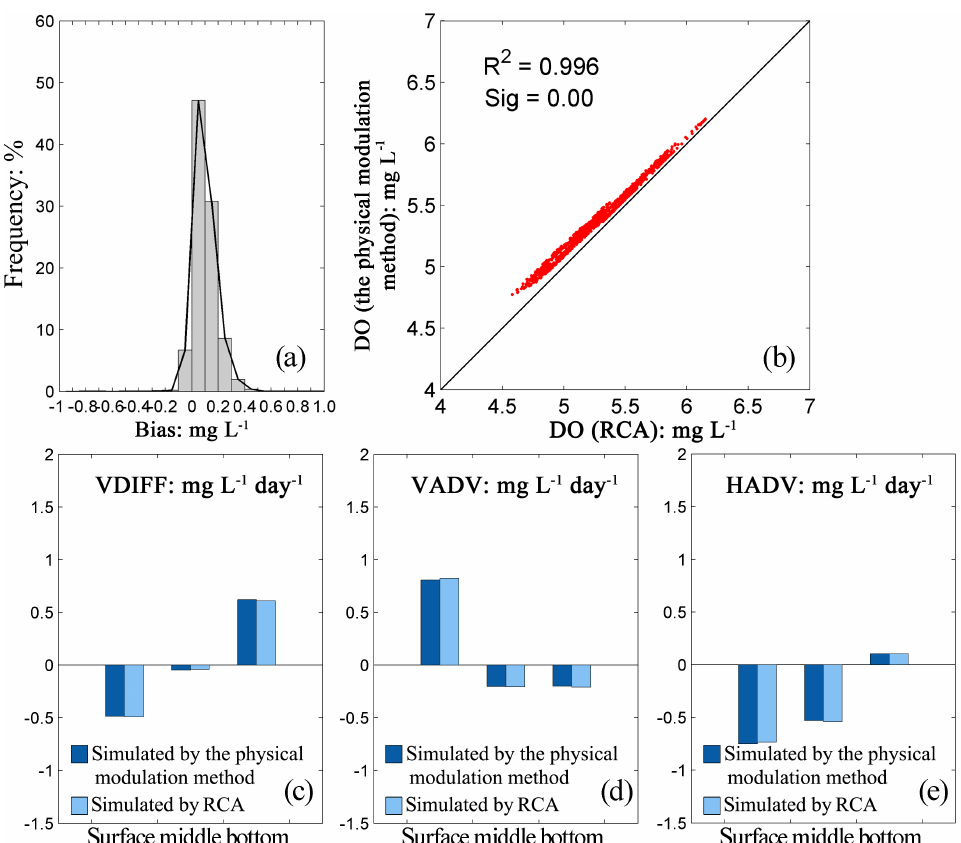
Figure 9. Comparisons for the physical modulation method and RCA: (a) frequency distribution as a function of the biases of the simulated DO concentrations; (b) the DO concentrations in the main PRE (denoted by the red box in Fig. 8); (c) the vertical DO diffusive fluxes; (d) the vertical advective DO fluxes; (e) horizontal advective DO